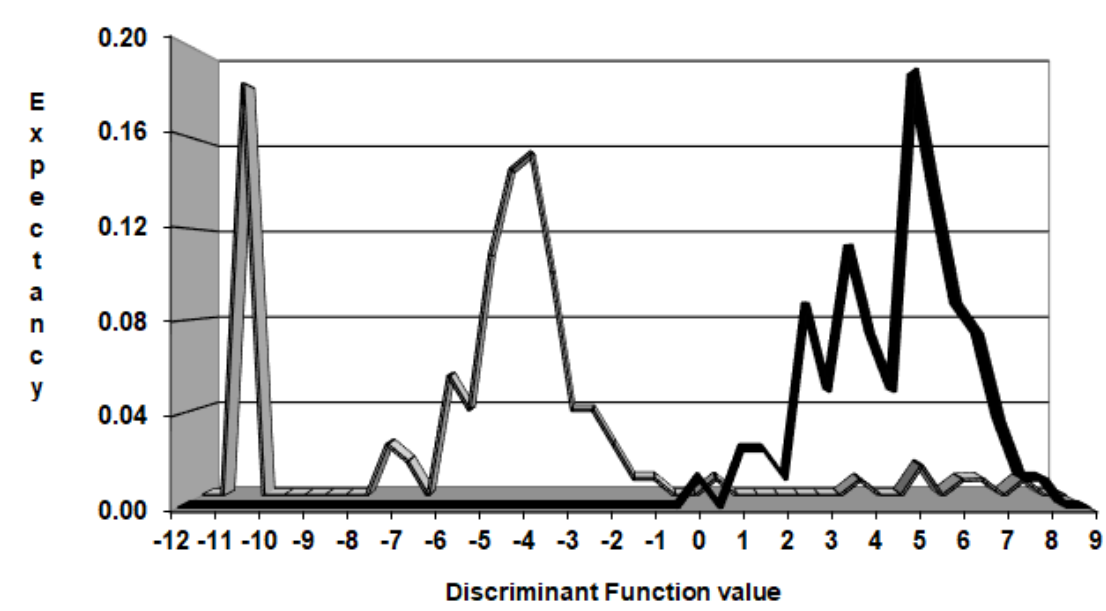
Figure 6. Pharmacological distribution diagram for anti-SARS-CoV-2 drugs. Figure 6 . Pharmacological distribution diagram for anti-SARS-CoV-2 drugs. Once the chemo-mathematical pattern of drugs is determined with docking score values against Mpro, it is possible to virtually screen for novel drugs that may have anti- SARS2 activity. The molecules with potential anti-SARS-2 activity (1) should be labeled as active by classification models (DF Class_6LU7 and ANN Class_6LU7 ); (2) should have a predicted docking score lower than − 5 kcal/mol (MLR reg_6LU7 and/or ANN reg_6LU7 ), and finally (3) be commercially available. Molecular structures of the final pool of compounds selected by virtual screening are shown in Figure 7.